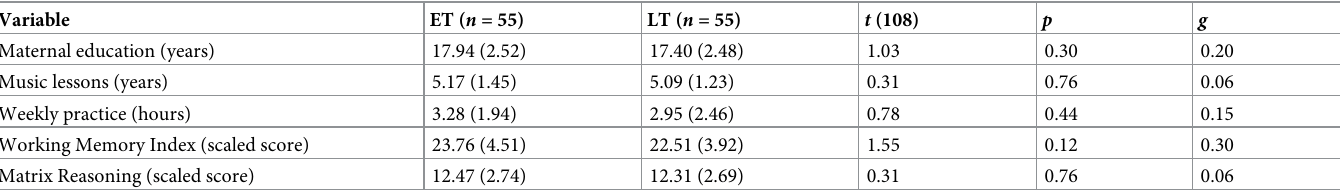
Table 1. Matched demographic, practice-related and cognitive variables in early-trained (ET) and late-trained (LT) musicians; ET < 5 � LT ( n = 110). Variable